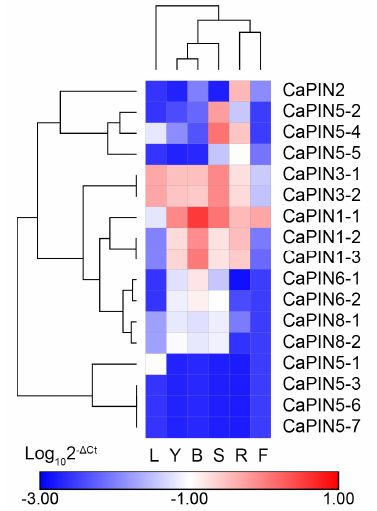
Figure 4. Expression pattern of PIN genes in different tissues of C. arabica determined by qRT-PCR: L, Y, B, S, R and F represent mature leaf, young leaf, bud, stem, root and fruit, respectively.